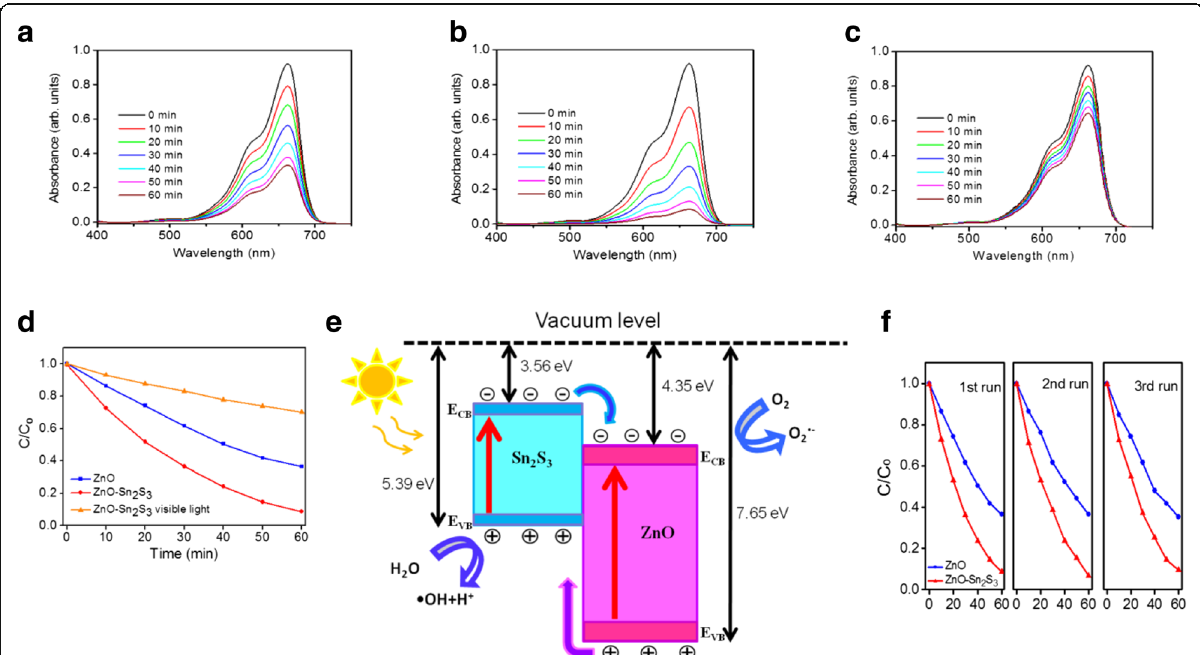
Fig. 5 Intensity variation of absorbance spectra of MB solution vs. degradation duration containing various nanorods samples under light illumination. a Pure ZnO nanorods under solar light illumination. b ZnO – Sn 2 S 3 nanorods under solar light illumination. c ZnO – Sn 2 S 3 nanorods under visible light illumination. d C / C o vs. irradiation time curves for MB solution with various nanorod samples under light illumination. e A schematic of band alignment and charges transfer of the ZnO – Sn 2 S 3 heterostructure under light illumination. f Recycled performance (three test runs) in the presence of ZnO – Sn 2 S 3 nanorods for photodegradation of MB